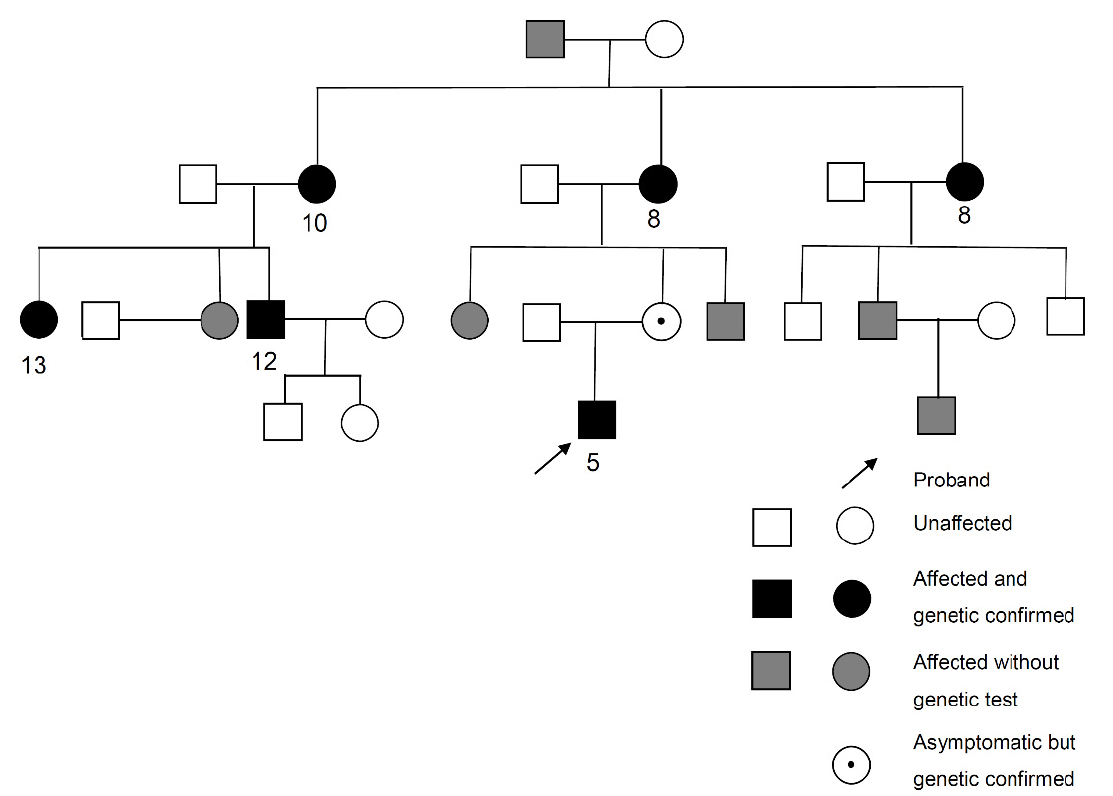
Figure 2. Pedigree and age of onset in each patient of Proband No. 12 family. Arrow: Proband No. 12.